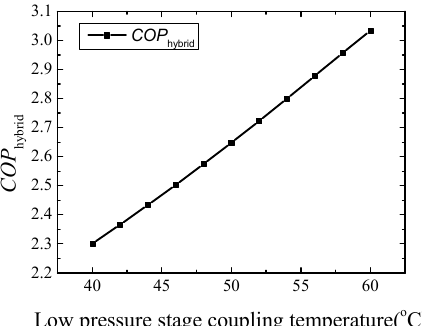
Figure 7. Effect of low pressure stage coupling temperature on coupling cycle COP.